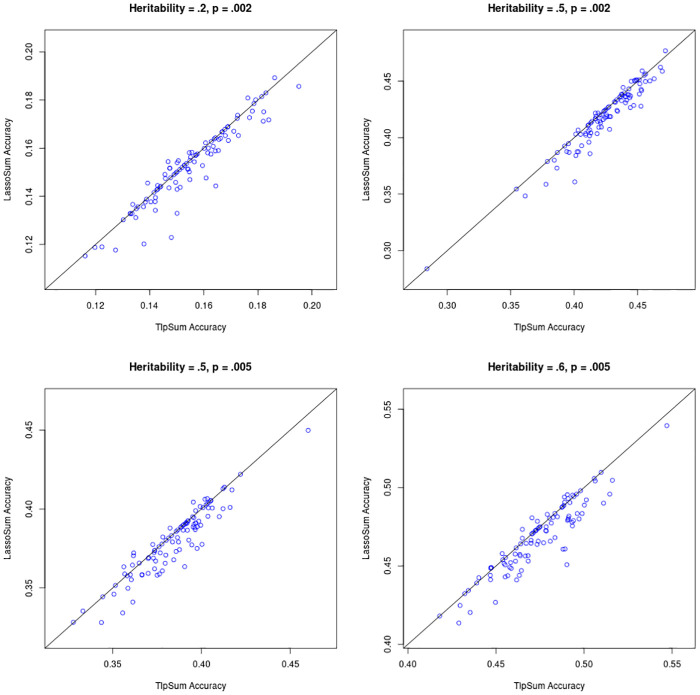
Predictive r2 on out-of-sample data for TlpSum and LassoSum for each of the 100 replications at each of the four simulation settings.Lines are at a 45 degree angle through the origin, and not a line of best fit. Points below the line indicate better performance of TlpSum.